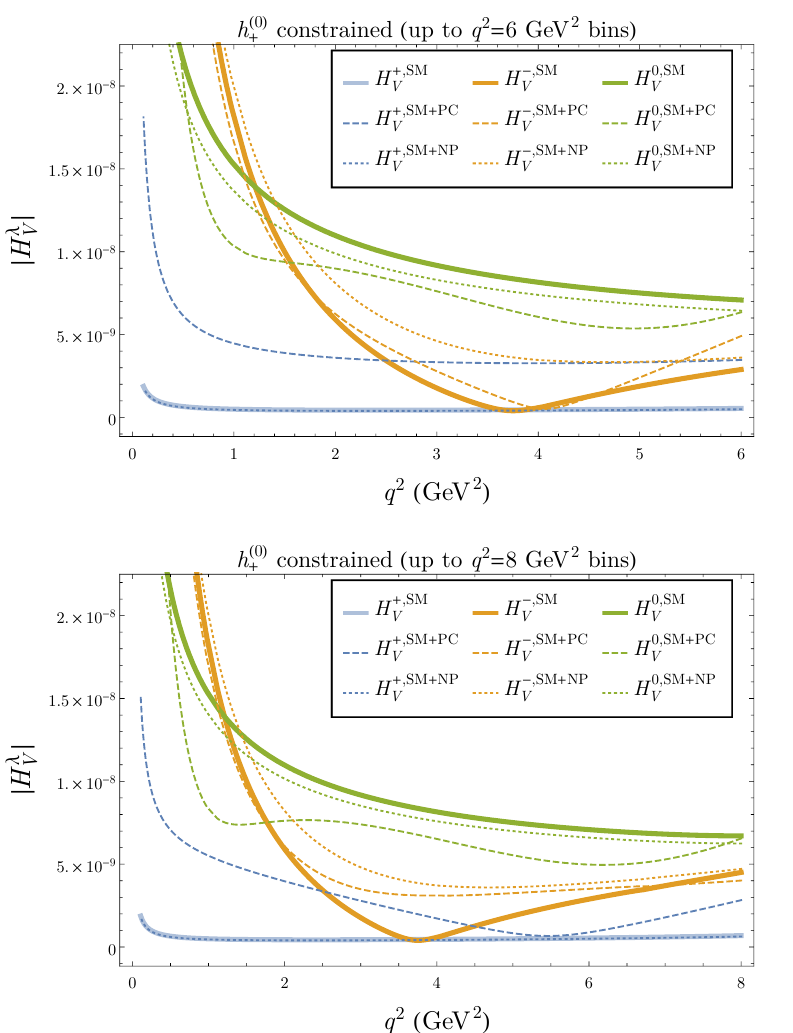
Figure 8 . Behaviour of absolute values of H + and \SM + NP" are shown with solid, dashed and dotted lines, respectively. Assuming h (0) constrained in the (cid:12)t for power corrections.